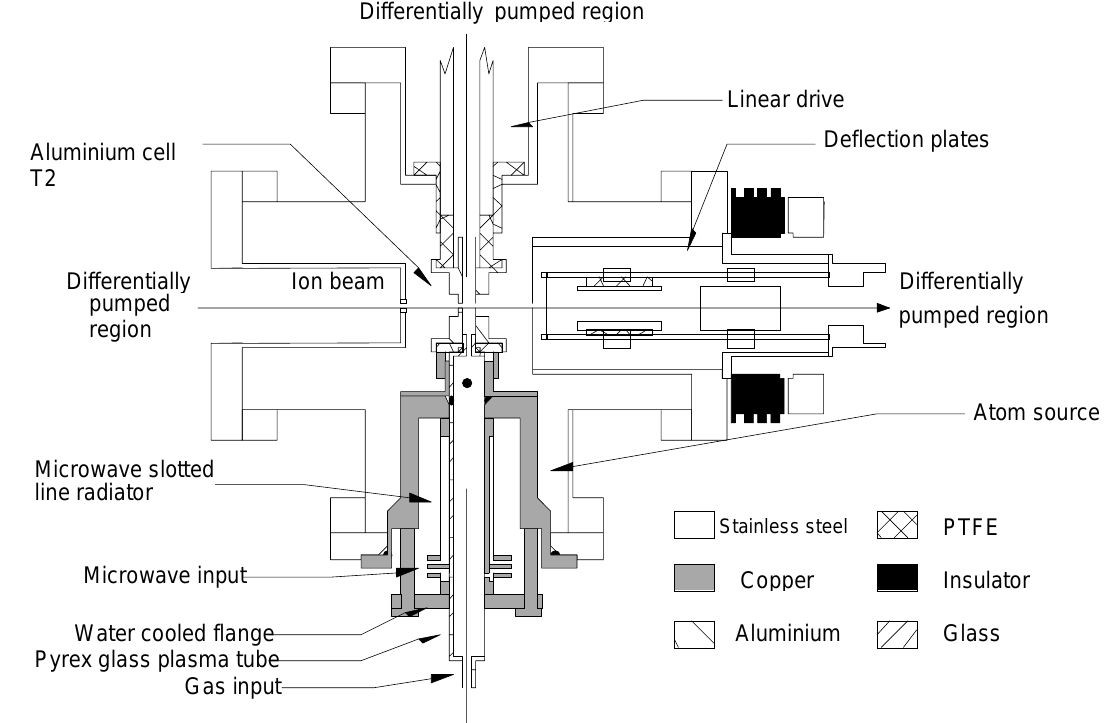
Figure 3: Schematic diagram of the microwave driven atomic hydrogen